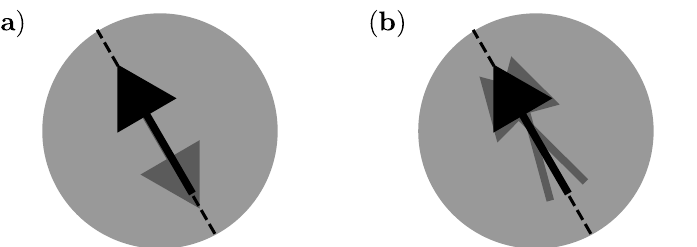
Figure 2. Representation of the superparamagnetic ( a ) and blocked ( b ) regimes under Néel